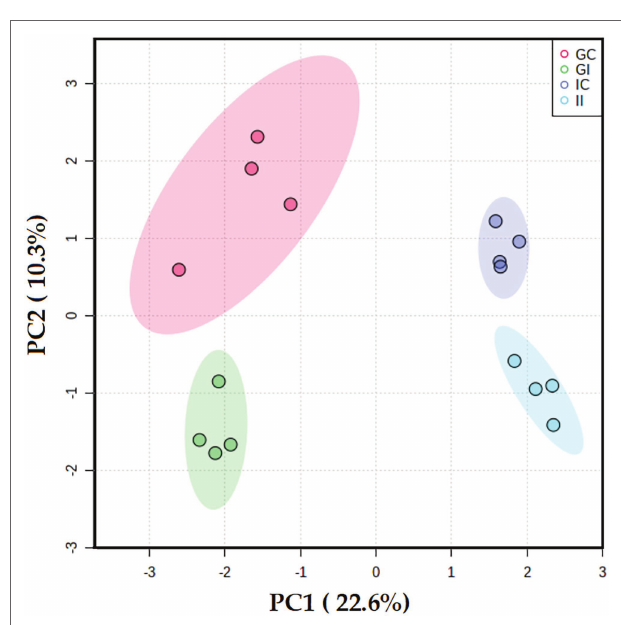
FIGURE 5 | Principal component analysis differentiated the potato leaf phosphoproteomes of potato plants (Gladiator and Iwa) with roots non- inoculated and inoculated by Spongospora subterranea . GI, Gladiator infected; GC, Gladiator control; II, Iwa infected; and IC, Iwa